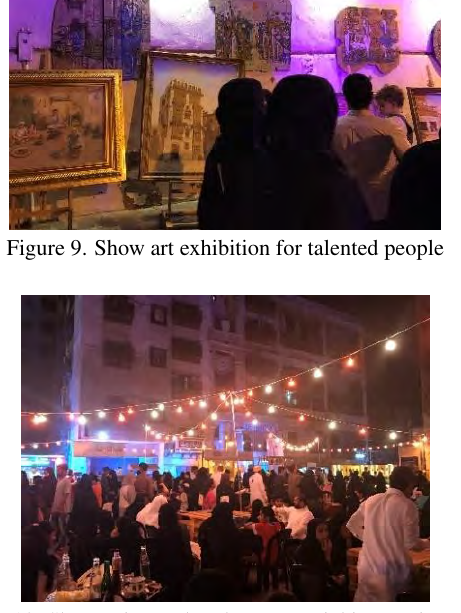
Figure 10. Show using end nodes as a social interaction